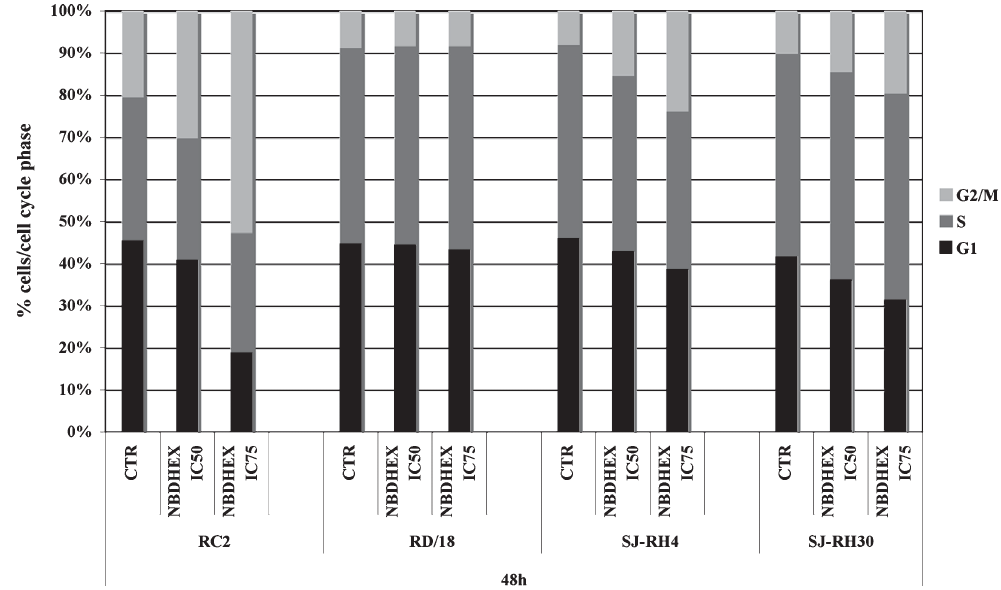
Supplementary Figure 3. Cell cycle phase perturbations induced by treatment for 48 hours with equitoxic doses of NBDHEX (corresponding to the IC50 or IC75 concentration of each cell line) in human rhabdomyosarcoma cell lines. Data refer to the percentage of cells for each cell cycle phase and are representative of at least two different